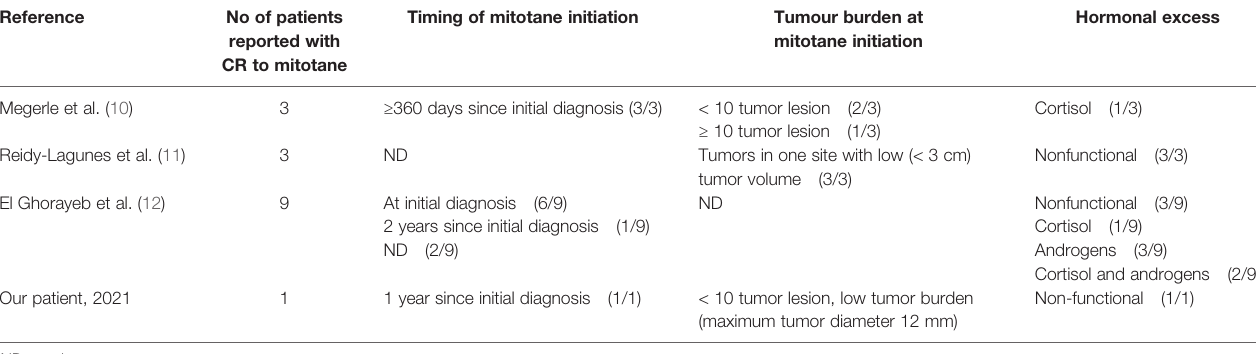
TABLE 2 | Clinicopathological features of adult patients with metastatic adrenocortical cancer reported as complete responders to mitotane monotherapy. Reference